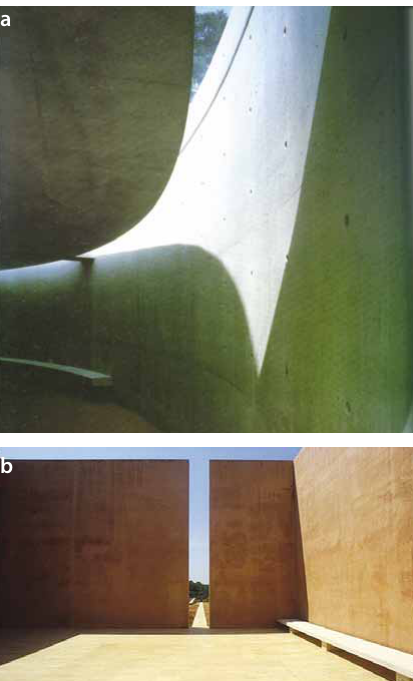
Fig. 4. Roden’s Crater project, near Flagstaff (a, b), Arizona.